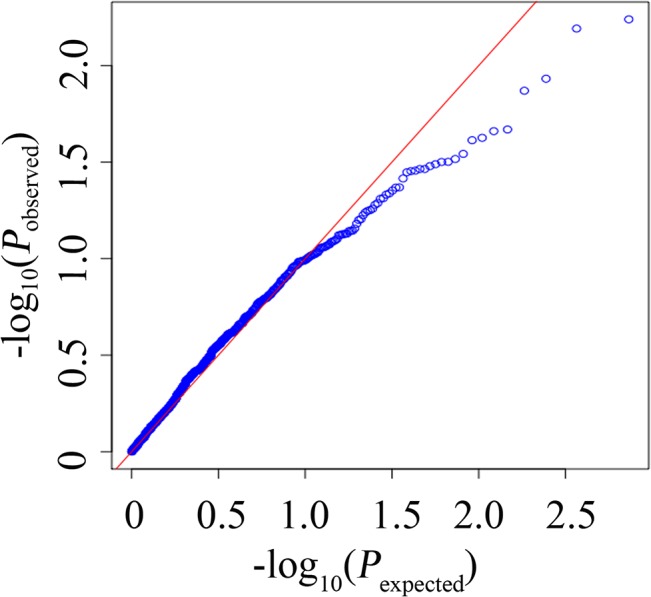
Quantile-quantile plot for glycogen content.